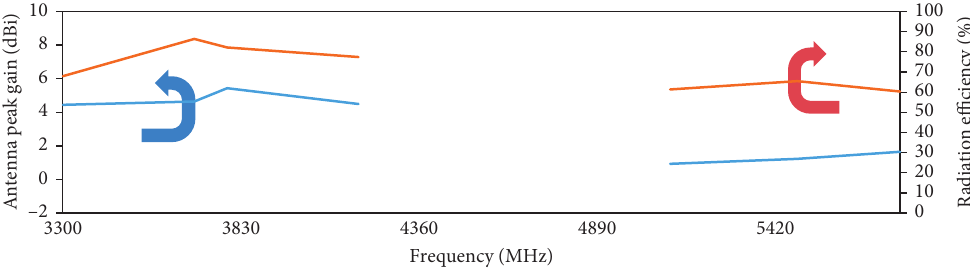
Figure 11: Gain and radiation efficiency measured for the developed antenna at 3300–5850MHz. Table 2: Arrangement of measured resonant, gain, efficiency, and bandwidth of proposed antenna. Resonance frequency